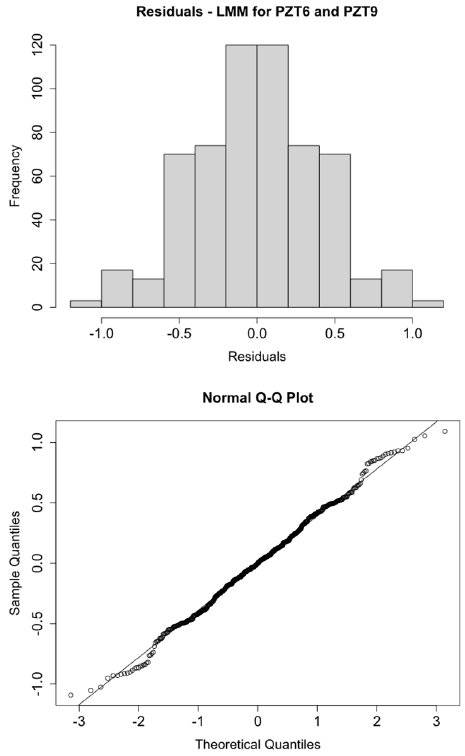
Figure 11. logRMSD histogram and Q-Q plot—Group 3.